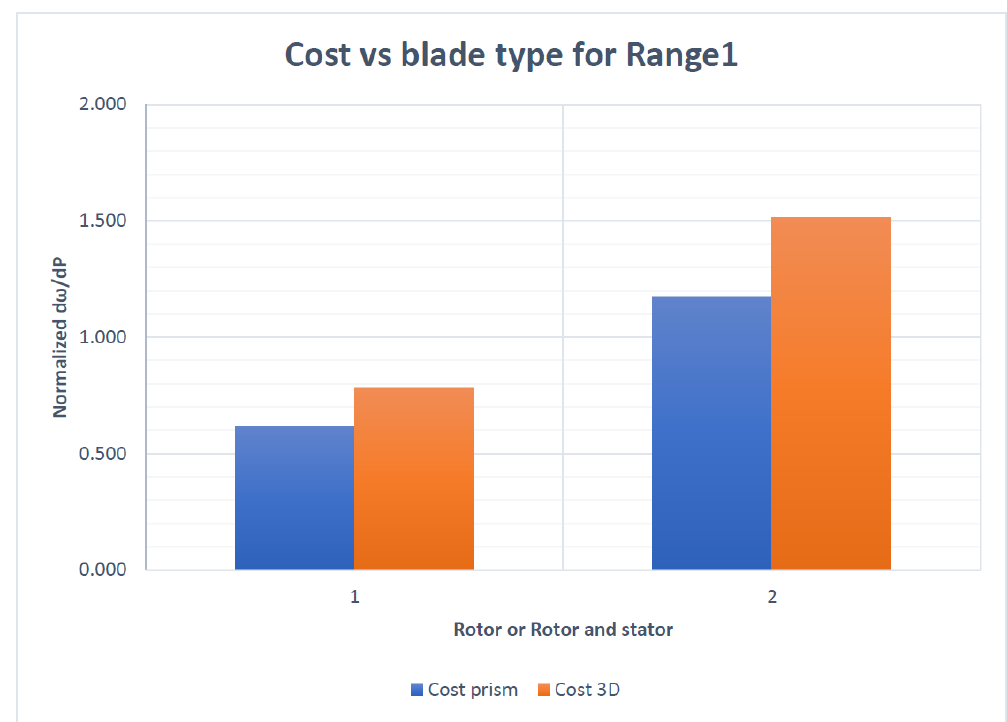
Figure 25. Manufacturing cost of the turbine rotors and rotors plus stators for prismatic vs. 3D blades.